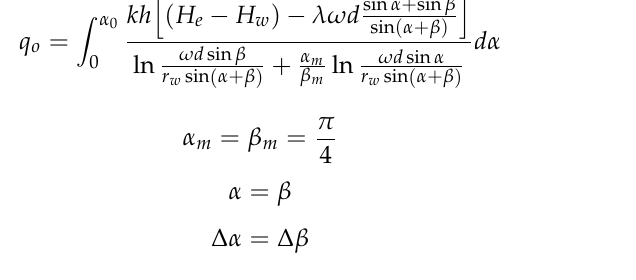
( b ) Figure 11. Rectangular well network after fracturing: ( a ) the entire well network; ( b ) the partition of a quarter of the well network.